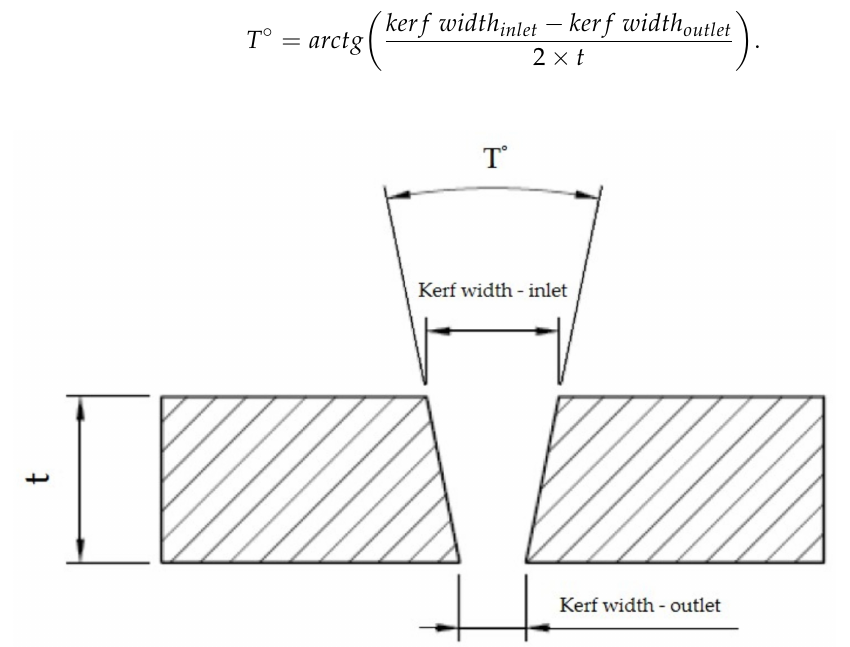
Figure 5. The principle of measuring the width of the cutting gap at the inlet and outlet of the water jet from the